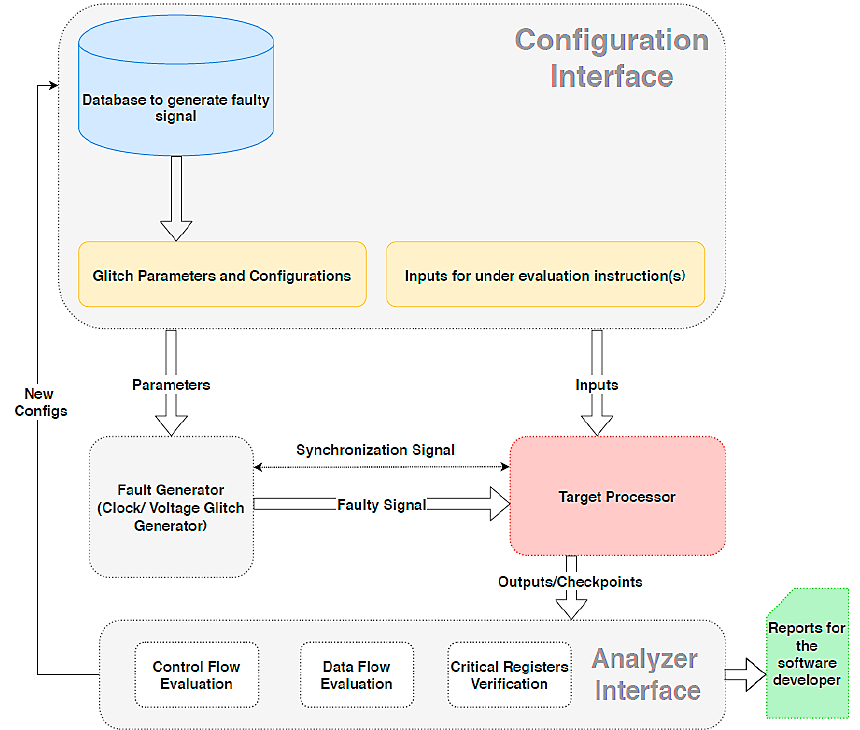
Figure 18. Framework of a clock and voltage fault injection platform.